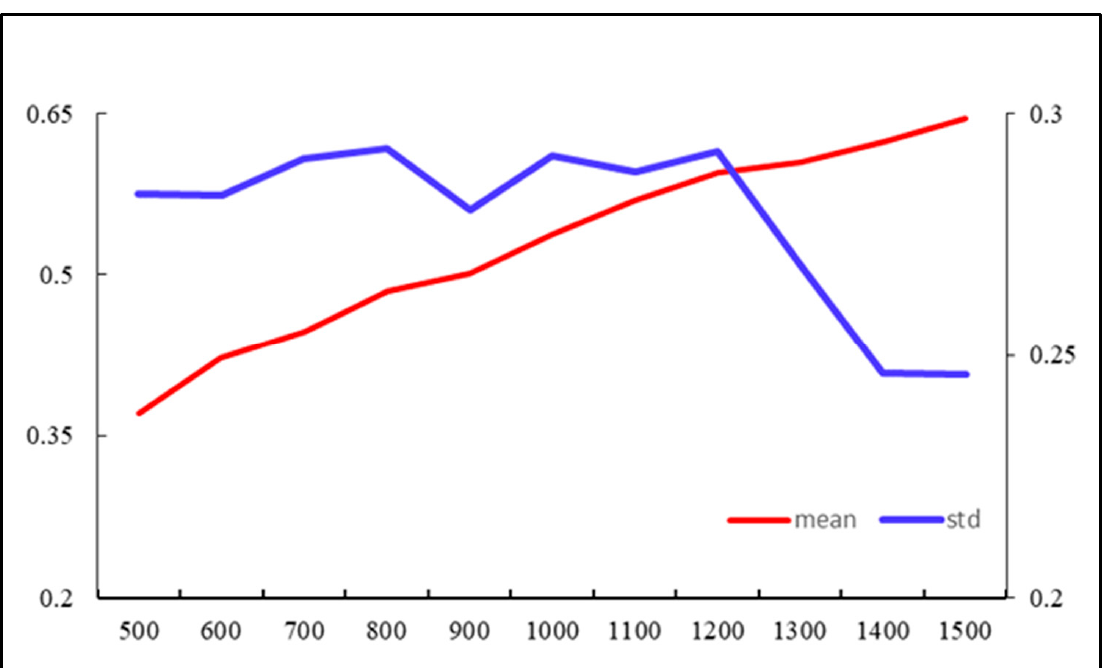
Figure A2. Diagram of the optimum scale of the grid.